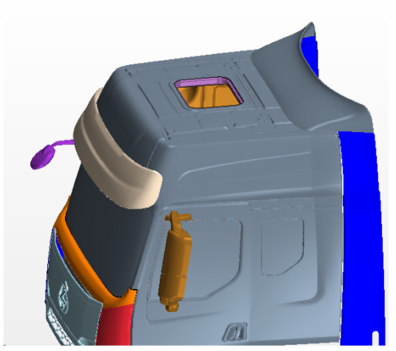
Figure 1. Geometric model of the commercial vehicle cab.